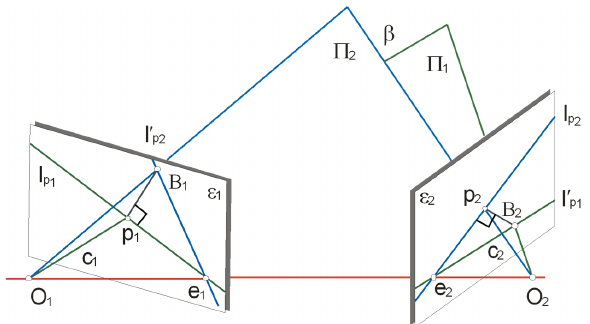
Figure 2. Computation of the dihedral angle β of the two epipolar planes defined by the optical axes of the two cameras (planes O 1 e 1 p 1 , O 1 e 1 Β 1 on the left image and O 2 e 2 p 2 , O 2 e 2 Β 2 on the